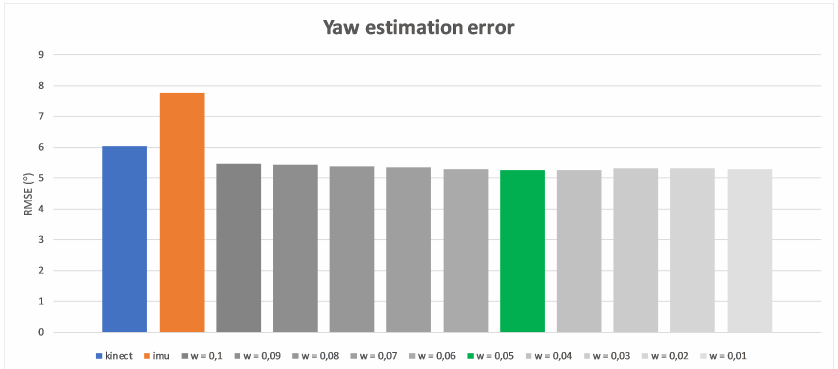
Figure 14. Influence of w θ to the yaw rotation estimation error.